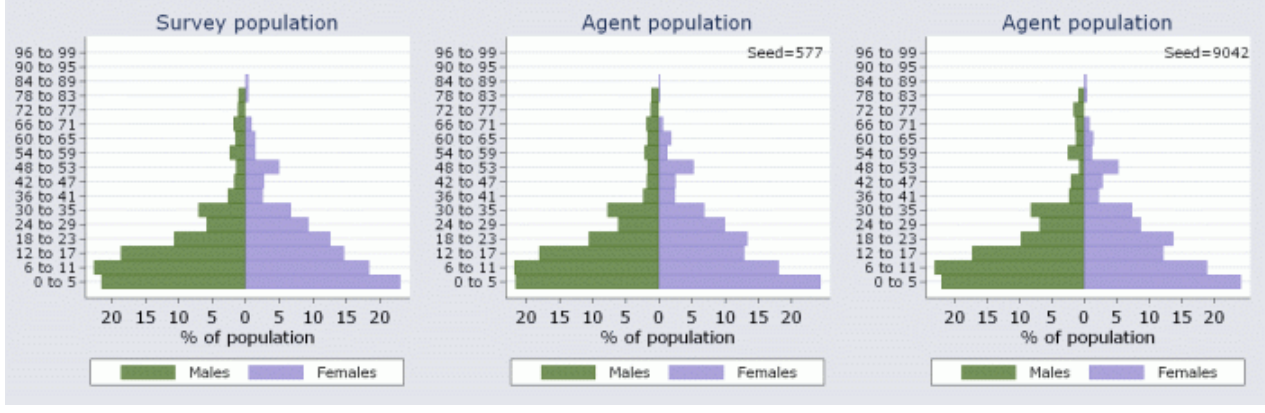
Fig. 5. Population pyramids for survey and one agent population